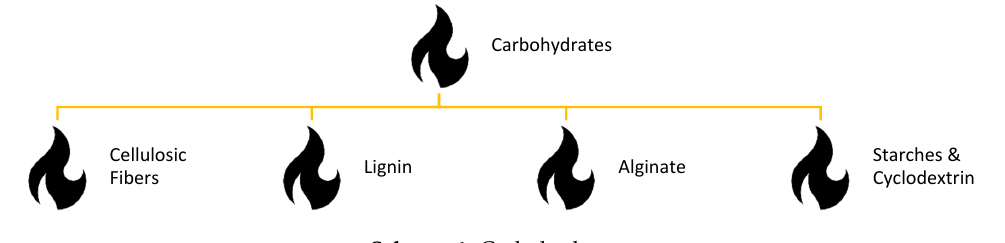
Table 5. Cellulosic fiber compositions